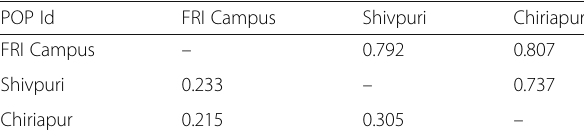
Table 7 Nei ’ s original measures of genetic identity (above diagonal) and genetic distance (below